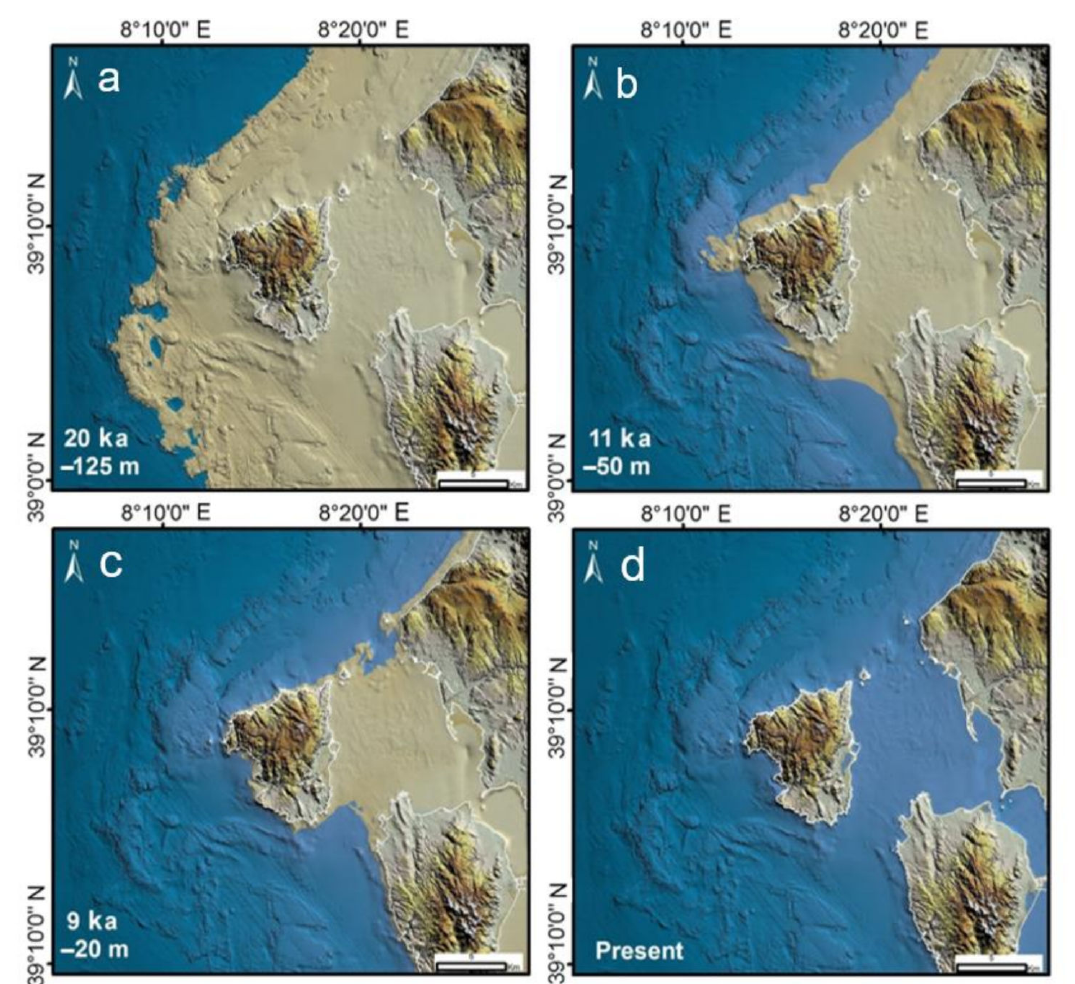
Figure 17. Reconstruction of the palaeo-landscape evolution of the San Pietro continental shelf since the LGM to present: ( a ) LGM; ( b ) Younger Dryas; ( c ) Holocene, Mesolithic; ( d )